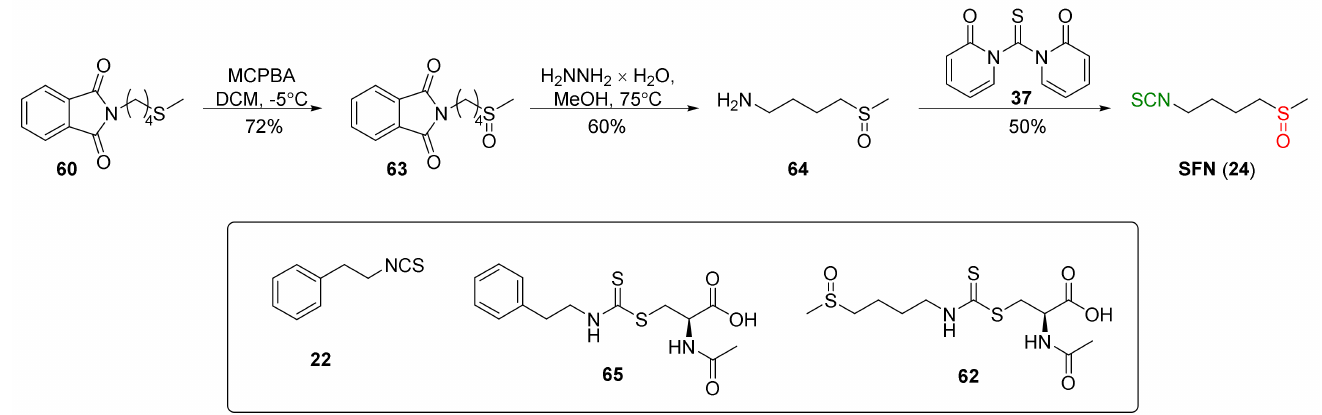
Figure 17. Synthesis of SFN using 1,1 (cid:48) -thiocarbonyldi-2,2 (cid:48) -pyridone ( 37